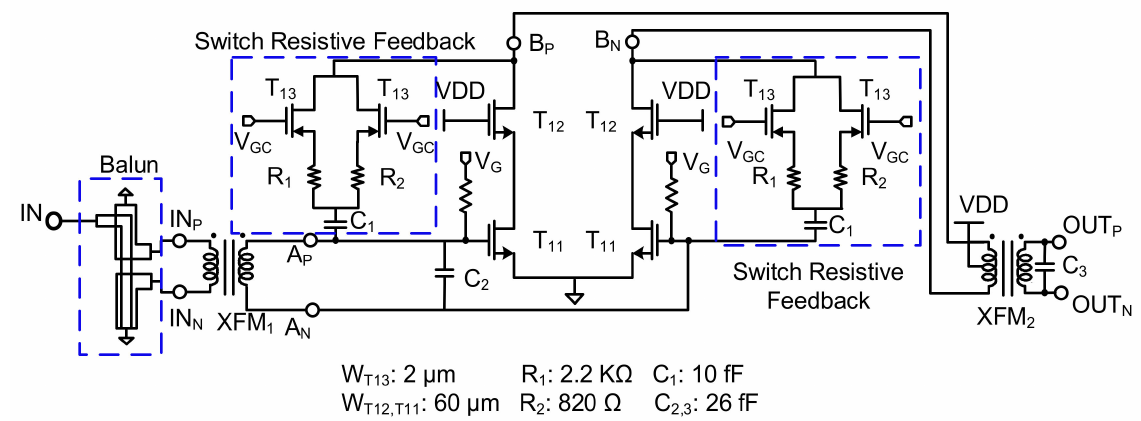
Figure 3. Schematic of 60 GHz single to differential amplifier.